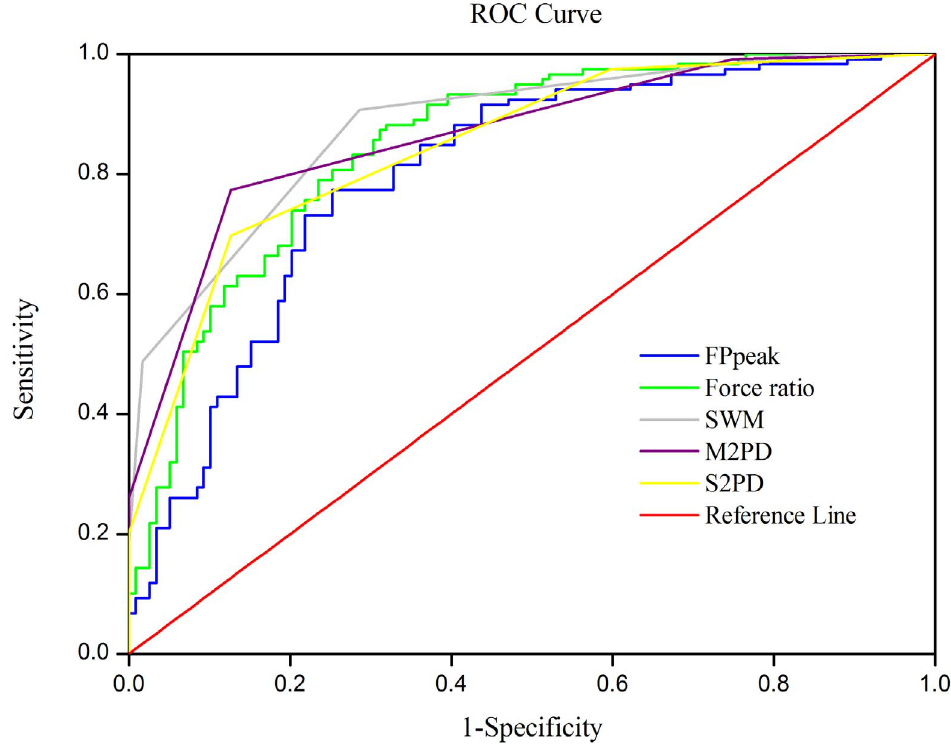
Figure 5. Constructed ROC curves for functional sensibility and traditional sensibility tests.